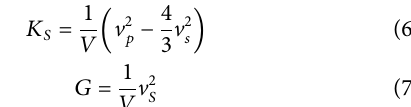
0.84 Fe 0.16 ) 2 SiO 4